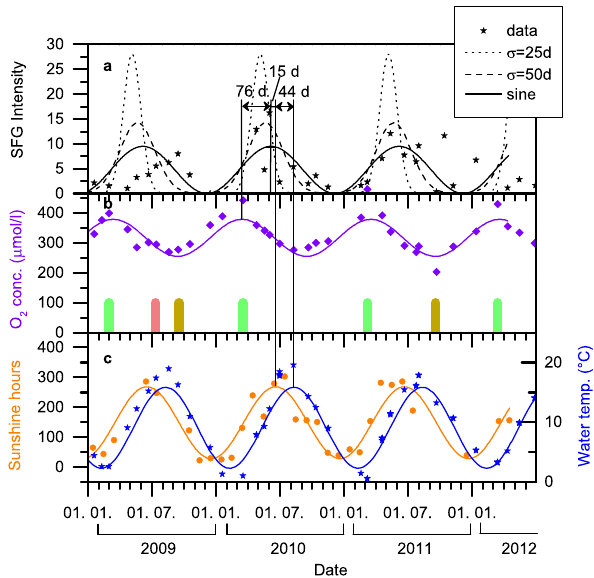
Fig. 4. Analysis of seasonal trends. (a) Overall SFG intensity in comparison with periodic model functions. (b) Oxygen concentra- tion. The bars indicate spring (green), summer (red) and autumn (brown) algal blooms, as far as the data were available. (c) Sunshine duration of the respective months and surface water temperature to- gether with sinusoidal